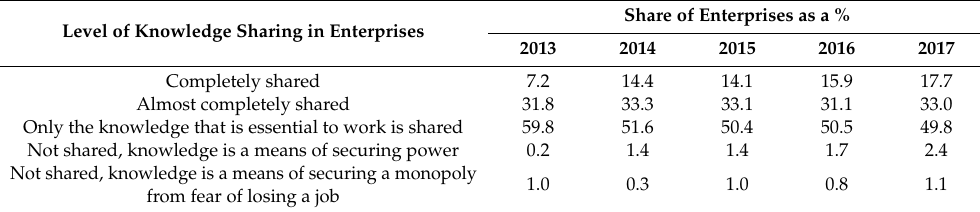
Table 4. Level of knowledge sharing in enterprises.